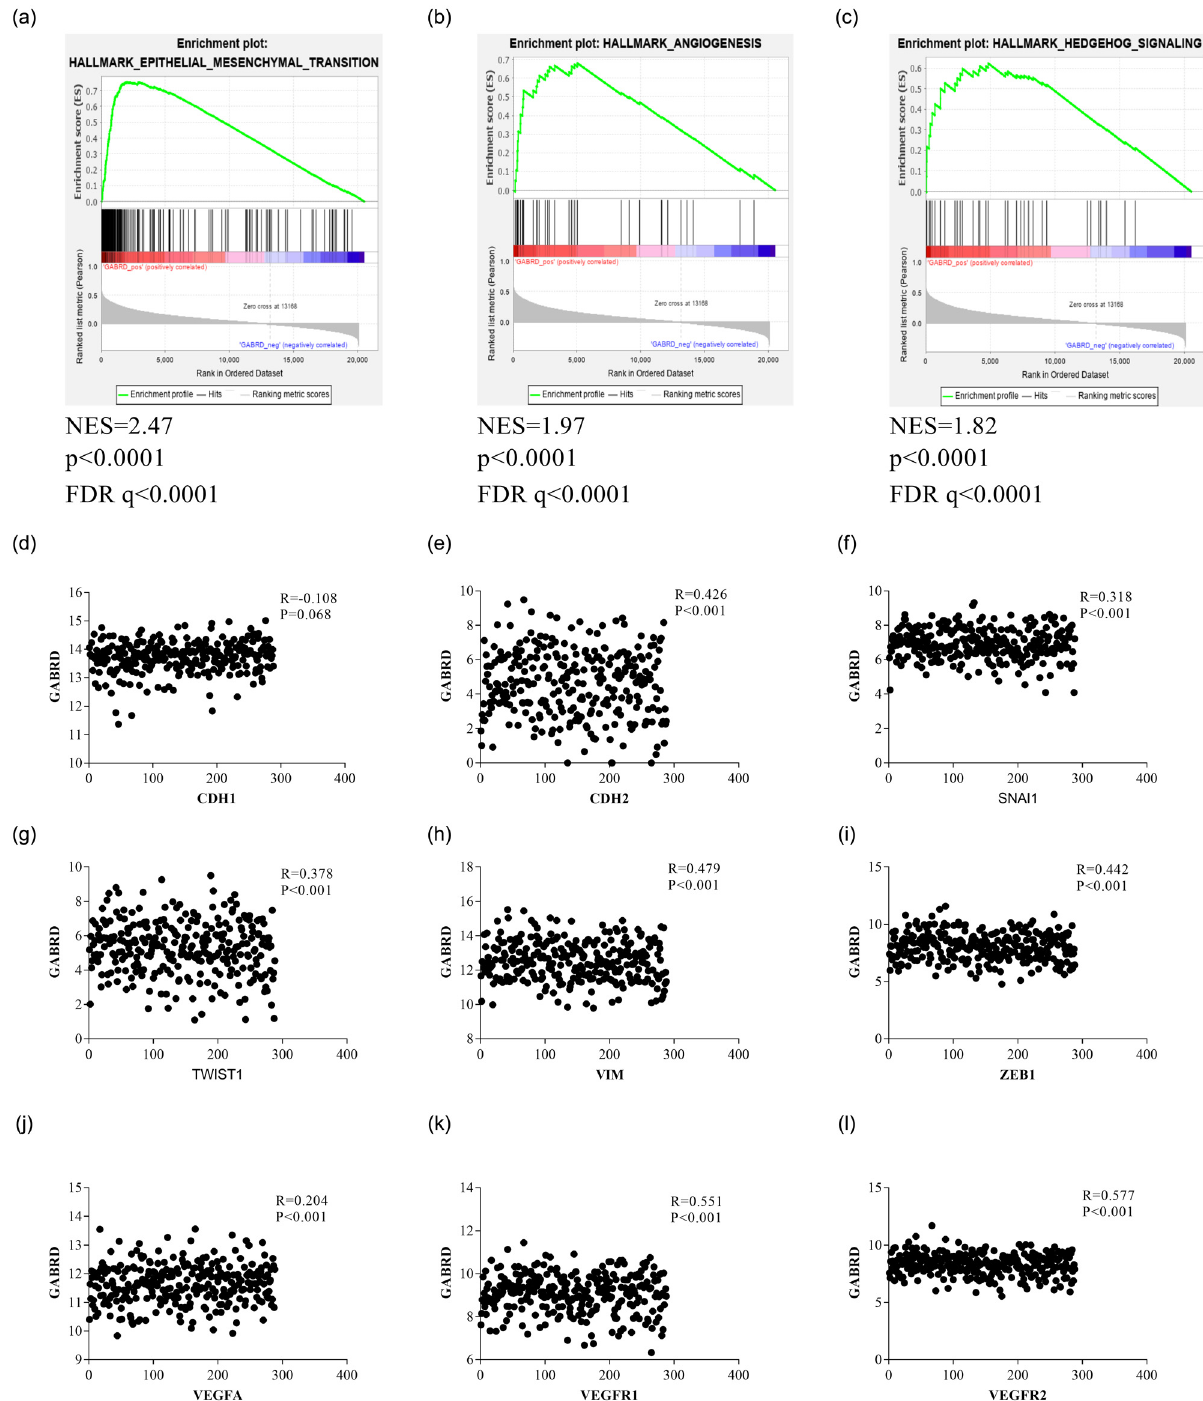
Figure 5: Potential mechanisms underlying the role of GABRD in CRCs. A GSEA was performed using the TCGA - COAD dataset to explore possible mechanisms underlying GABRD ’ s role in carcinogenesis and progression of CRCs. The results indicated that a high expression of GABRD was positively correlated with hallmark gene sets de fi ning epithelial – mesenchymal transition, angiogenesis, and hedgehog signaling. Gene – gene correlation analyses demonstrated that GABRD was signi fi cantly correlated with several key genes associated with EMT and angiogenesis. Abbreviations: CDH1, cadherin 1; CDH2, cadherin 2; CRC, colorectal cancer; FDR, false discovery rate; GABRD, gamma - aminobutyric acid type A receptor subunit delta; GSEA, gene sets enrichment analysis; NES, normalized enrichment score; SNAI1, snail family transcriptional repressor 1; TCGA - COAD, the cancer genome atlas colon adenocarcinoma; TWIST1, twist family BHLH transcription factor 1; VEGFA, vascular endothelial growth factor A; VEGFR, vascular endothelial growth factor receptor; VIM, vimentin; ZEB1, zinc fi nger E - box binding homeobox